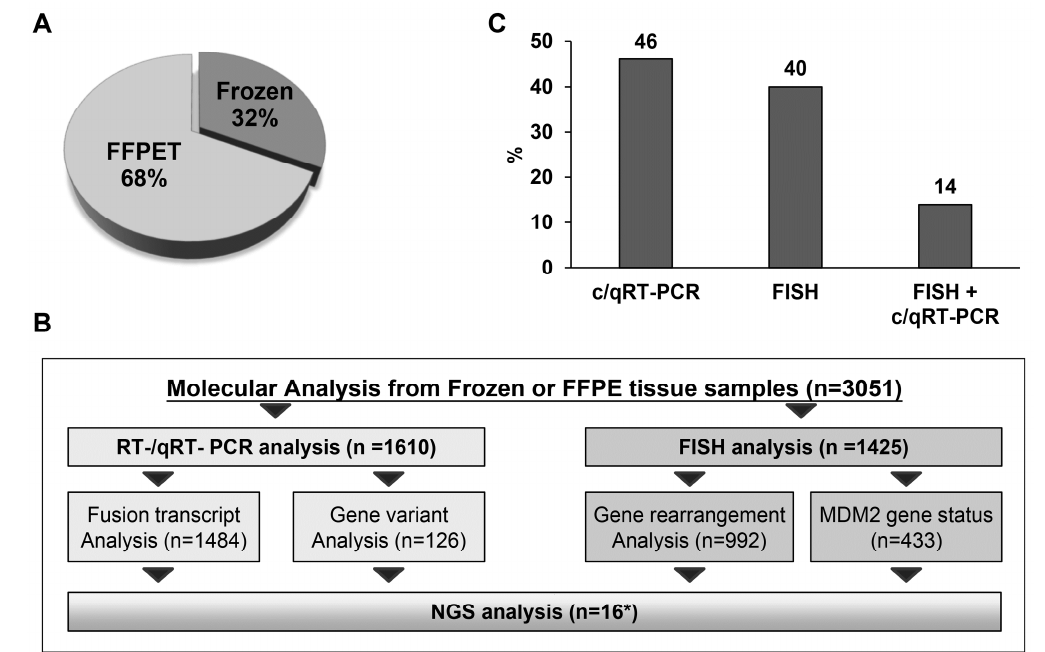
Figure 1. Samples and molecular analyses carried out in our institution in 15 years of activity. ( A ) The diagram shows the distribution of the type of material analysed in this study. ( B ) Schematic representation of all molecular analyses carried out in our institution in fifteen years of activity. ( C ) The diagram shows the percentage of molecular investigations performed, based on type of analysis to evaluate the presence of fusion transcript, gene rearrangements, gene amplification and gene variation. (* for NGS the number corresponds to two years of